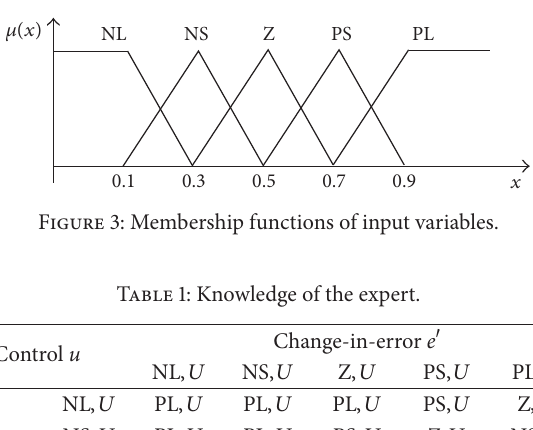
Figure 4: Transient response characteristic of Z number based (solid curve) and conventional fuzzy (dashed line)